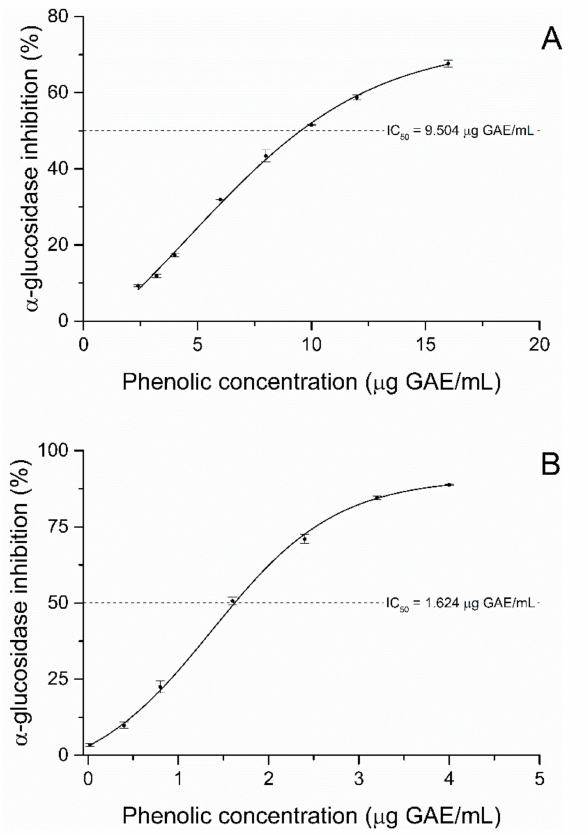
Figure 1. Dose-response curves of the inhibitory activity of ( A ) the soluble polyphenols (SPP) fraction and ( B ) the insoluble-bound polyphenols (IBPP) fraction on